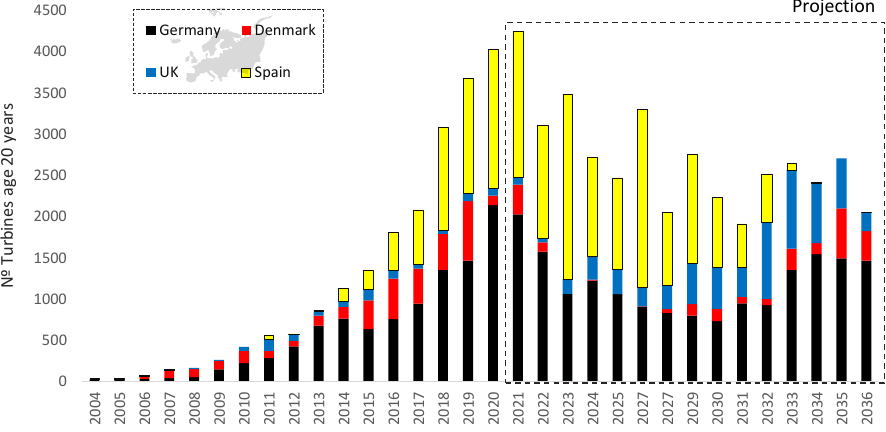
Figure 4. Number of turbines age 20 years. Germany, Denmark, UK, and Spain (source: own